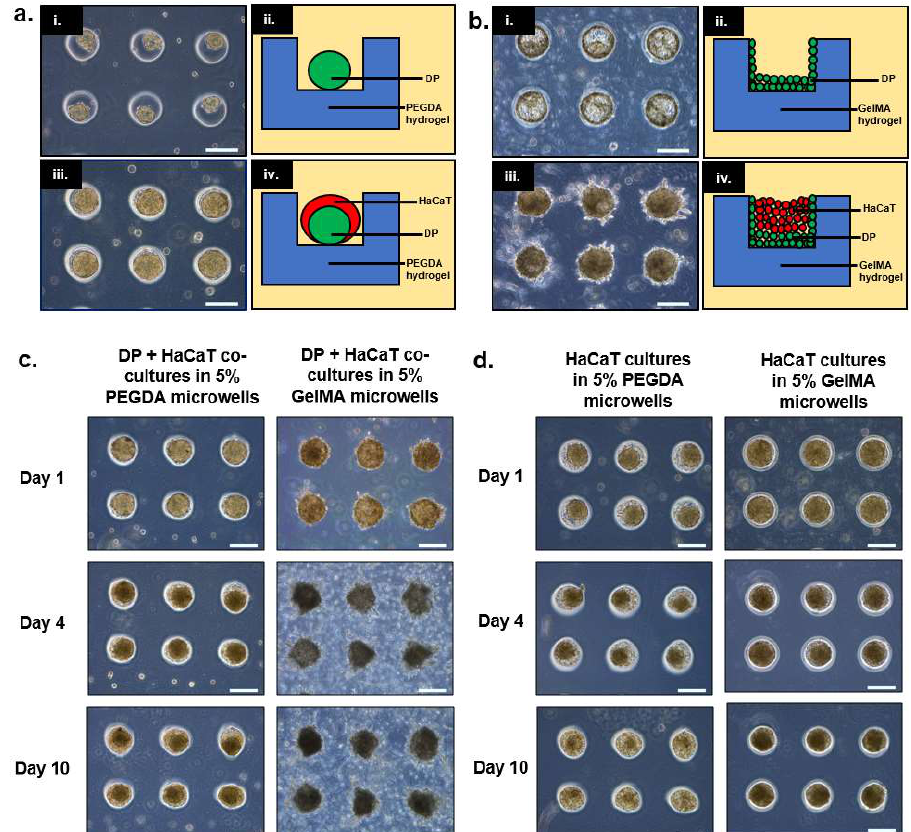
Figure 1. Sequential seeding of dermal papilla (DP) and HaCaT cells into poly (ethylene glycol) diacrylate (PEGDA) or gelatin methacrylate (GelMA) microwells yielded heterotypic cultures of different configurations. Exfoliation of HaCaT keratinocytes was observed in PEGDA microwells in both co-cultures and mono-cultures ( a (i)–(iv)). Light microscopic images showing DP and DP-HaCaT keratinocyte co-culture behavior and their corresponding schematic representation. DP aggregates were formed 24 h post-seeding into PEGDA microwells. Subsequently, HaCaT keratinocytes